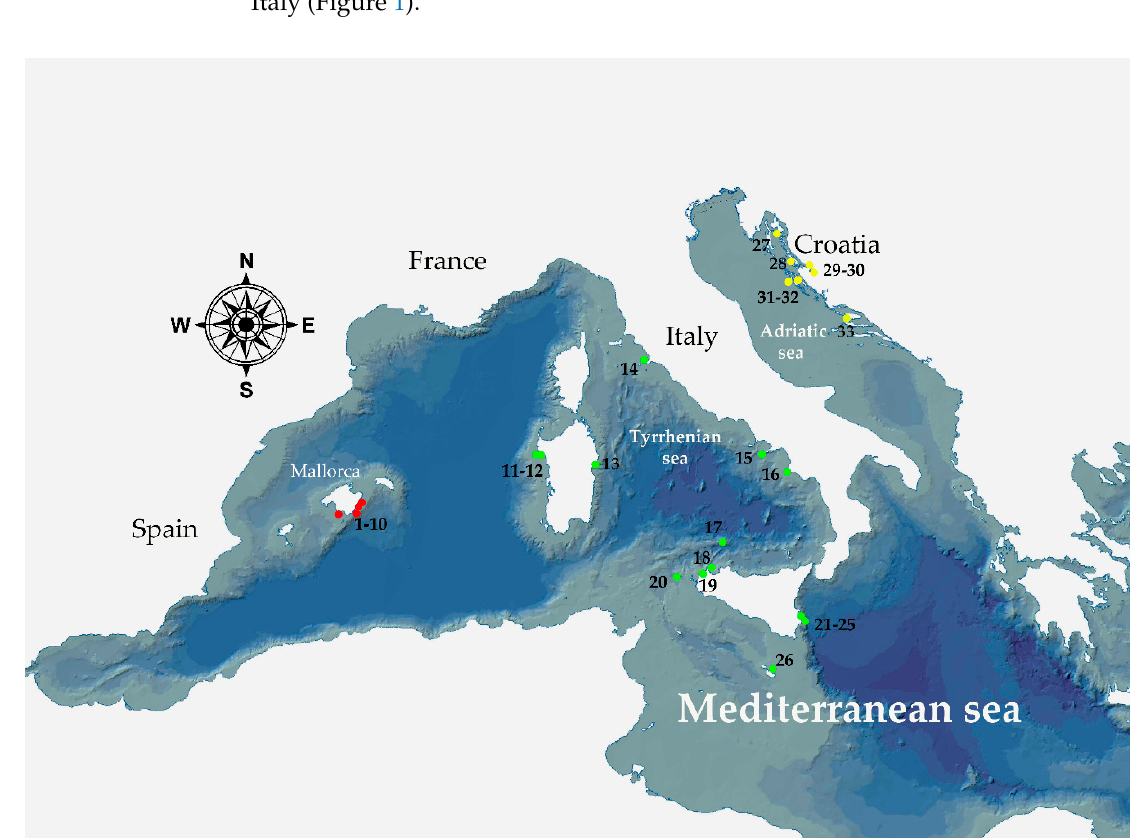
Figure 1. Overview map of the Mediterranean region showing the locations of the coastal caves discussed in this study. Specific information (latitude, longitude, sampling depths, dating method, and ages) is reported in Table 3 and 4.